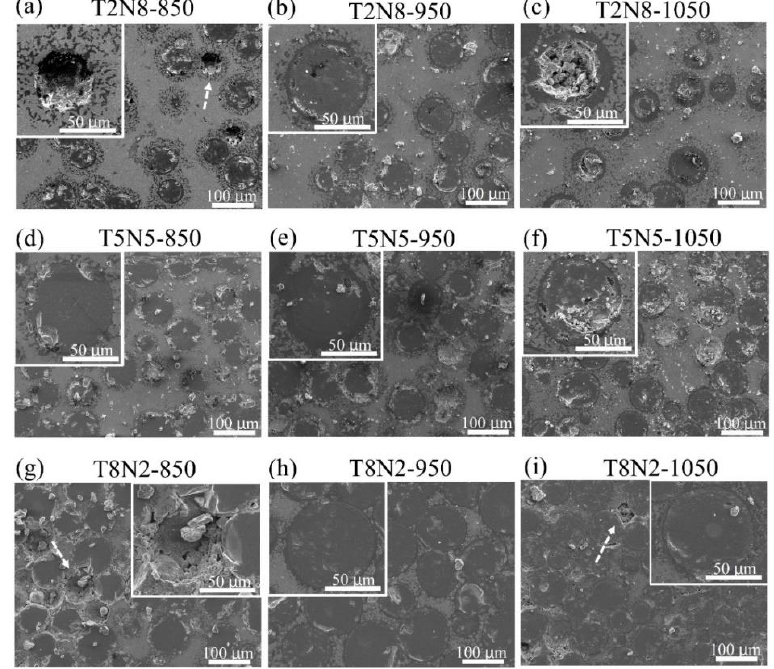
Figure 3. SEM micrographs of T2N5, T5N5 and T8N2 sintered at various temperatures. ( a ) T2N8-850, ( b ) T2N8-950, ( c ) T2N8-1050, ( d ) T5N5-850, ( e ) T5N5-950, ( f ) T5N5-1050, ( g ) T8N2-850, ( h ) T8N2-950 and ( i ) T8N2-1050.